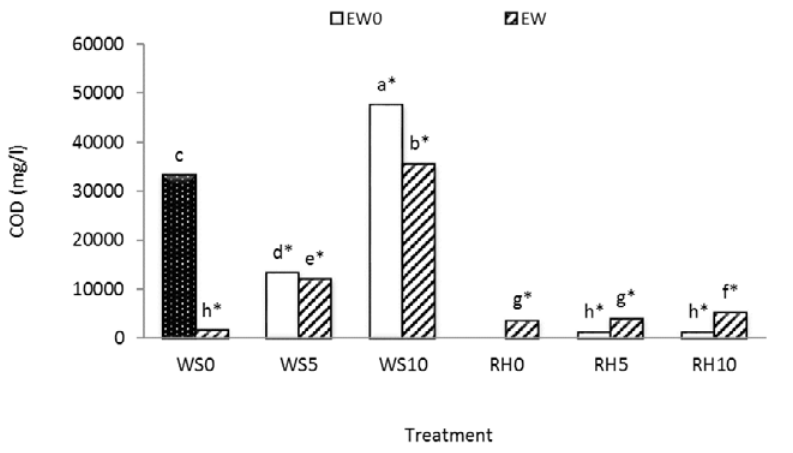
Figure 7. Effects of the treatments on COD of the wastewater EW0: without vermicomposting; EW: with vermicomposting; WS0: without wheat straw; WS5: 5% v/v wheat straw; WS10: 10% v/v wheat straw; RH0: without rice husk; RH5: 5% v/v rice husk; RH10: 10% v/v rice husk. Means in the same column followed by the same letter are not significantly different according to DMRT at (P≤0.05).